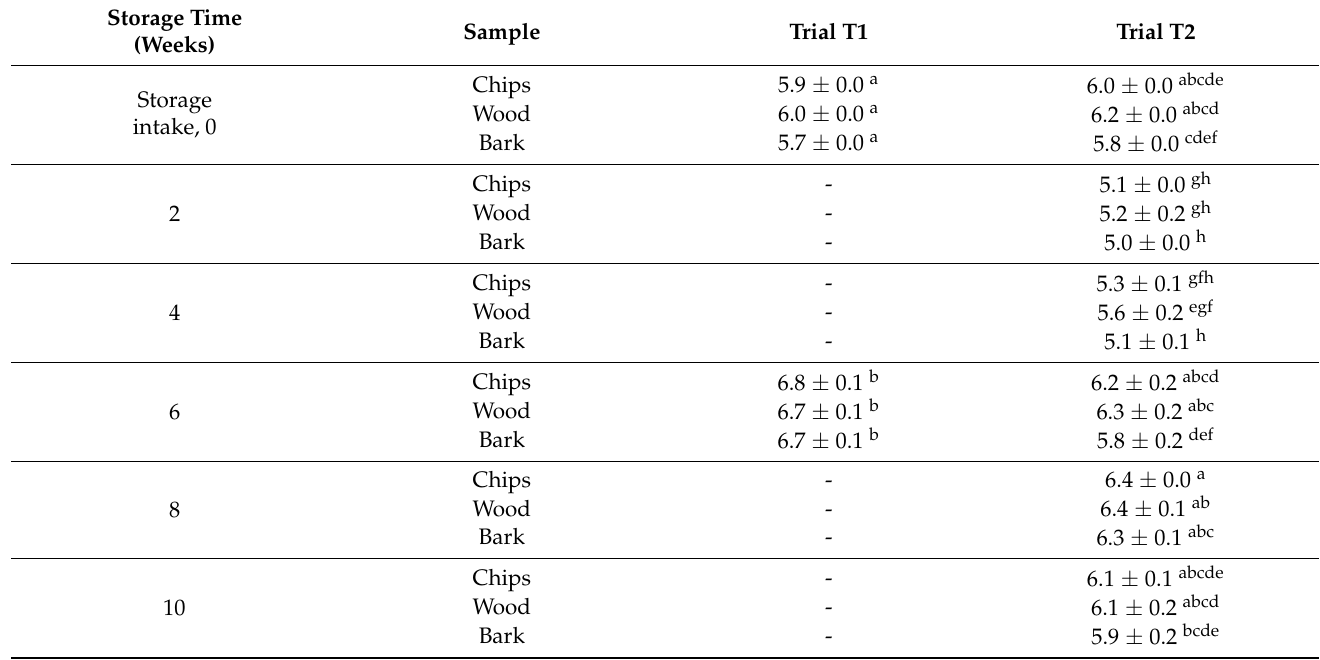
Table A6. Results of the pH analysis of the chips, wood and bark in trial T1 and T2; presented as mean ± standard deviation. Different letters indicate significant differences within one trial over storage time ( p < 0.05).